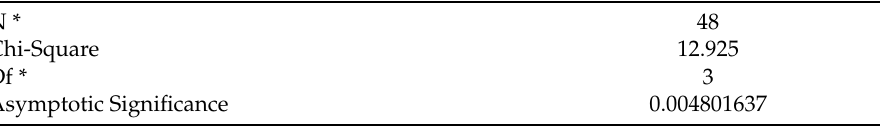
Table 3. Friedman test ( α = 0.05).